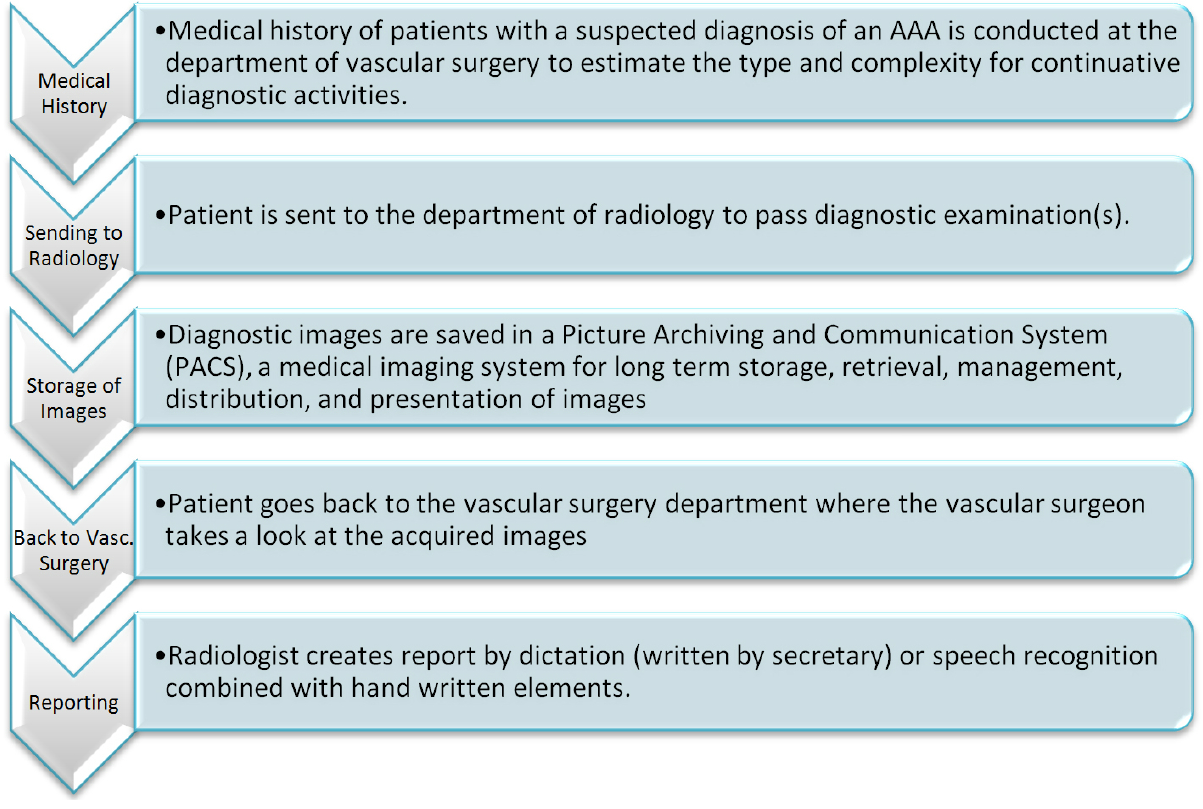
Figure 1. Related processes between departments of radiology and vascular